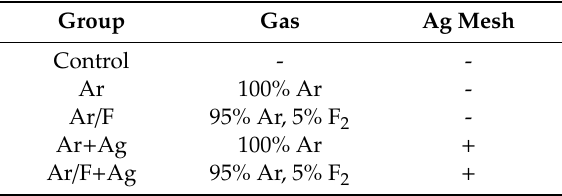
Table 1. Experimental groups.